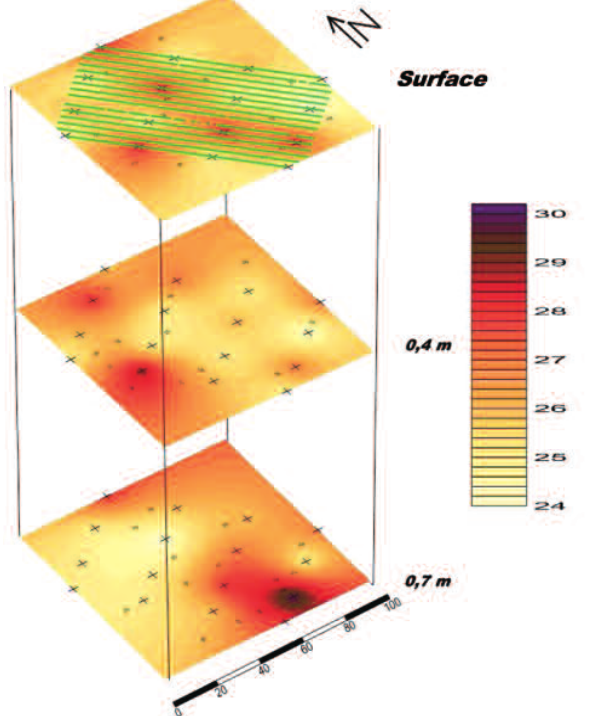
Figure 2: Spatial distribution of soil plasticity (apple trees illustrated as points on the surface layer) Table 2. Statistics of the coarse sand fractions (%) Depth Mean St. Dev.